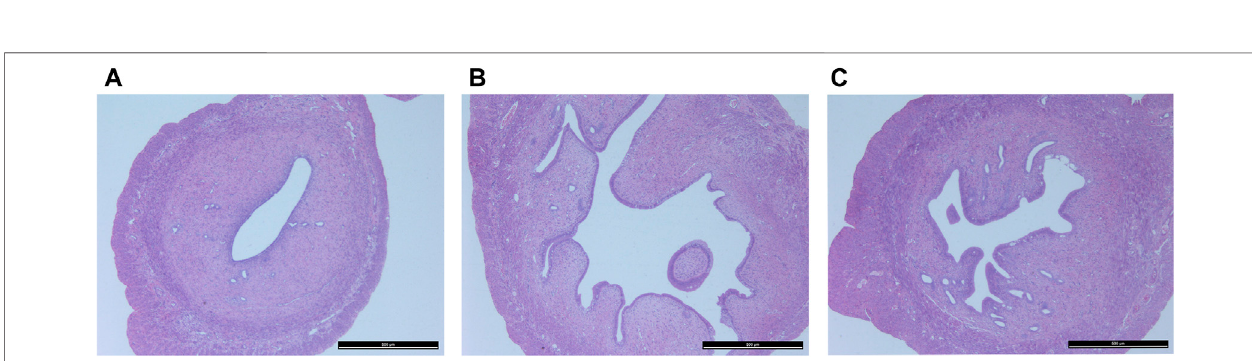
Frontiers in Pharmacology |